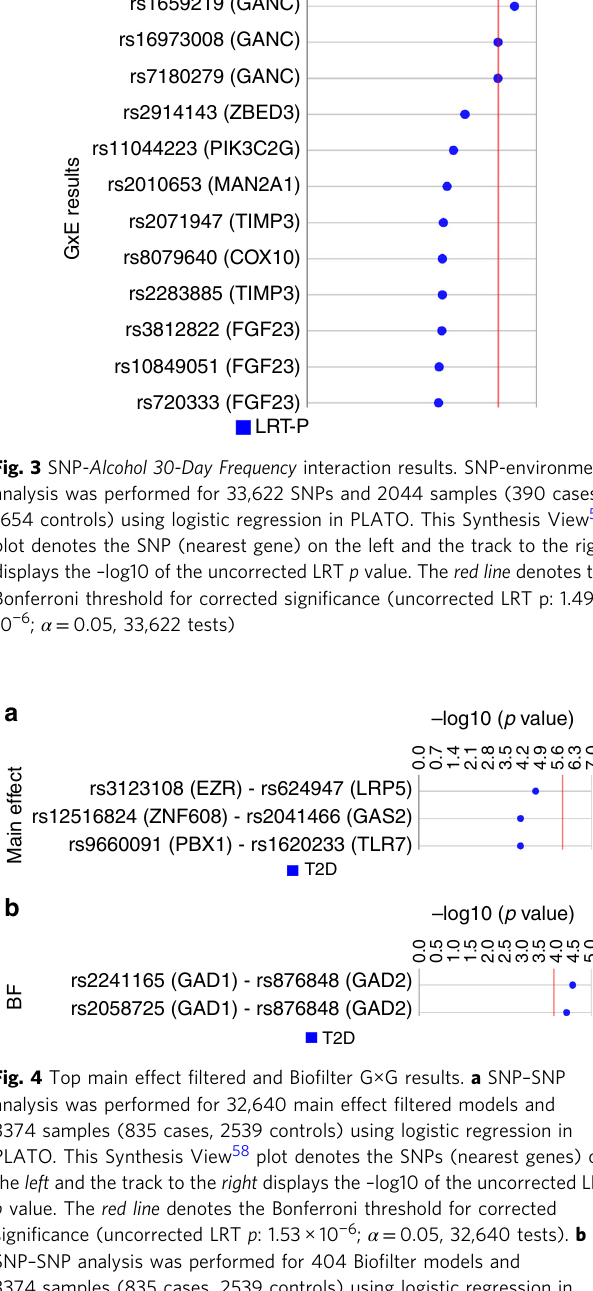
Fig. 4 Top main effect fi ltered and Bio fi lter G×G results. a SNP – SNP analysis was performed for 32,640 main effect fi ltered models and 3374 samples (835 cases, 2539 controls) using logistic regression in PLATO. This Synthesis View 58 plot denotes the SNPs (nearest genes) on the left and the track to the right displays the – log10 of the uncorrected LRT p value. The red line denotes the Bonferroni threshold for corrected signi fi cance (uncorrected LRT p : 1.53 × 10 − 6 ; α = 0.05, 32,640 tests). b SNP – SNP analysis was performed for 404 Bio fi lter models and 3374 samples (835 cases, 2539 controls) using logistic regression in PLATO. This Synthesis View 58 plot denotes the SNPs (nearest genes) on the left and the track to the right displays the – log10 of the uncorrected LRT p value. The red line denotes the Bonferroni threshold for corrected signi fi cance (uncorrected LRT p : 1.24 × 10 − 4 ; α = 0.05, 404